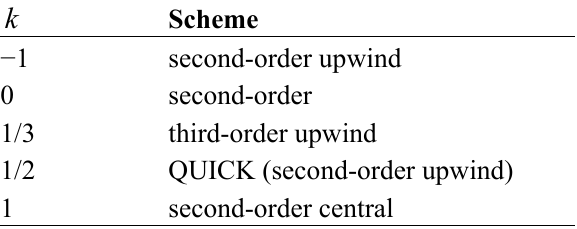
Table 13. Spatial accuracy of MUSCL interpolation for several values of parameter k